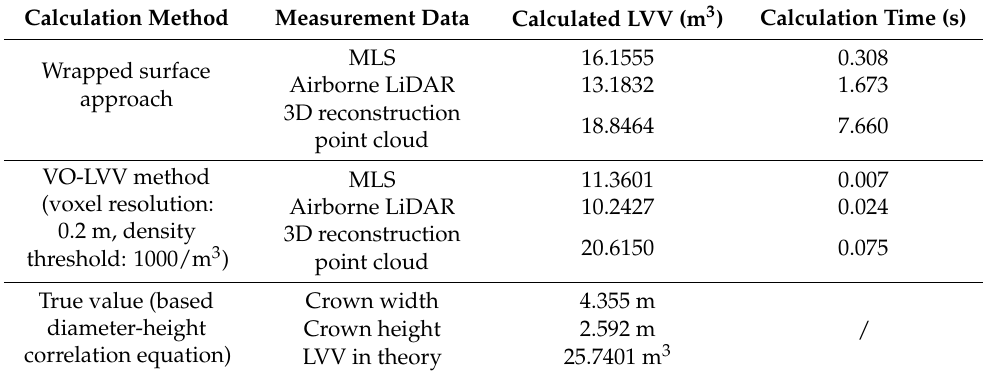
Table 3. Comparison of different LVV measurement methods (for a single tree